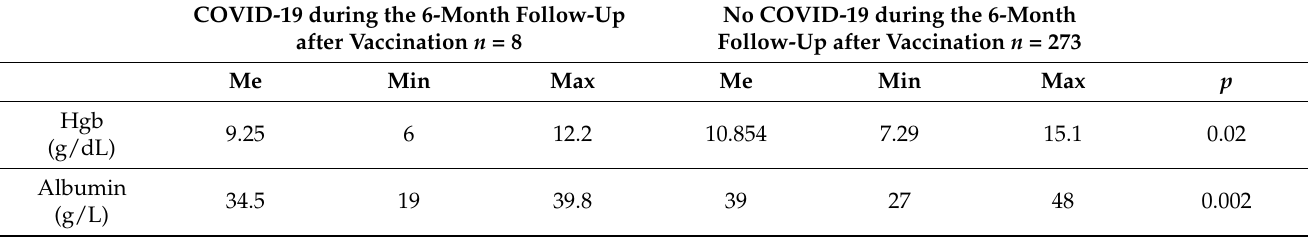
Table 4. Statistically significant differences between the groups with and without SARS-CoV-2